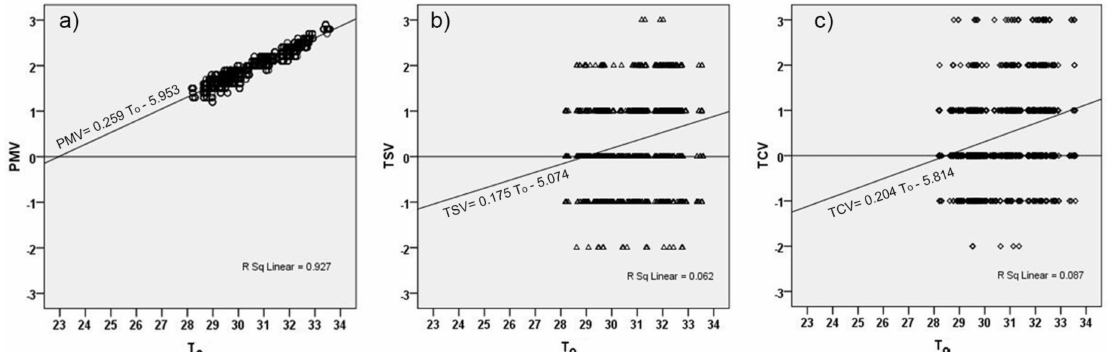
Figure 9. The scatterplot and regression between: ( a ) the operative temperature (T o ) and the PMV; ( b ) he operative temperature (T o ) and the TSV; and ( c ) the operative temperature (T o ) and the TCV (thermal comfort